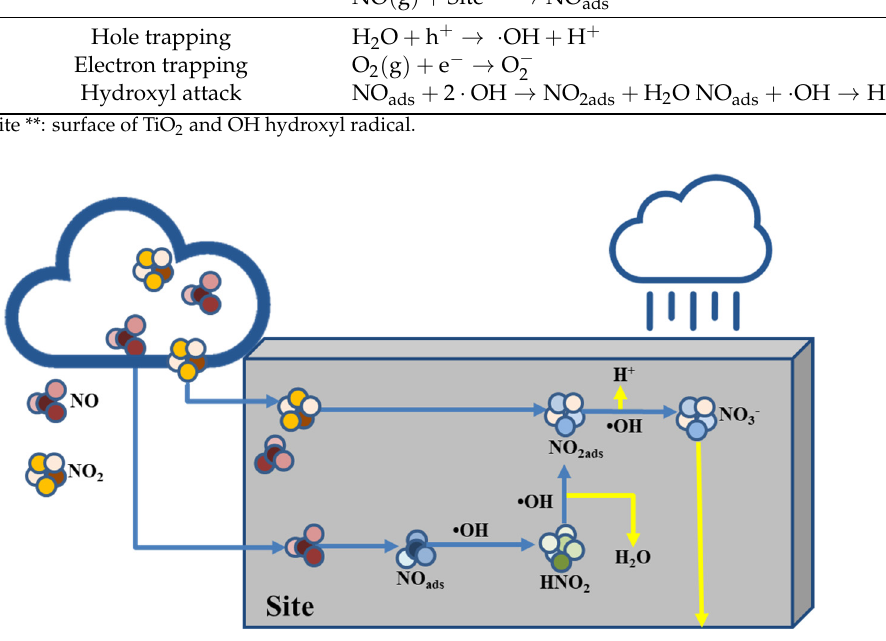
Figure 1. Mechanism for oxidation of NOx on the wall coated with TiO 2 .